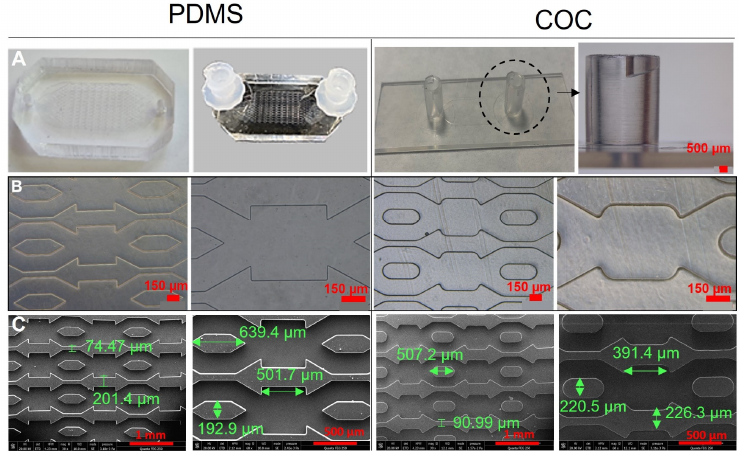
Figure 3. COC and PDMS biochips characterization: ( A ) biochips pictures, ( B , C ) phase contrast microscopy and MEB images, respectively.